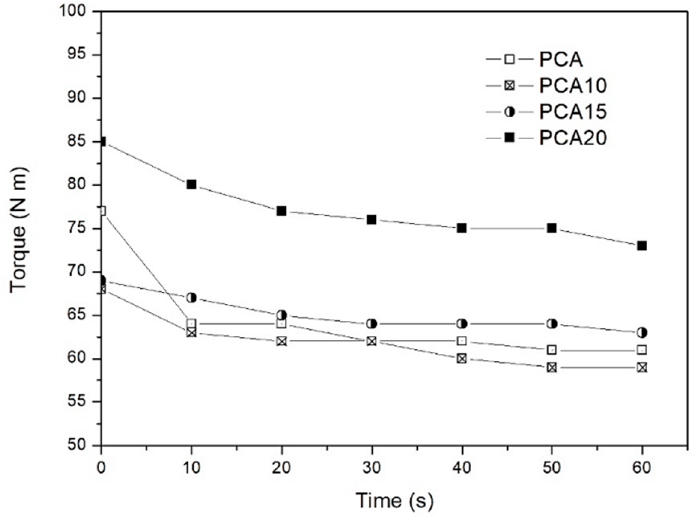
Figure 1. Torque-time curves obtained at 170 °C.